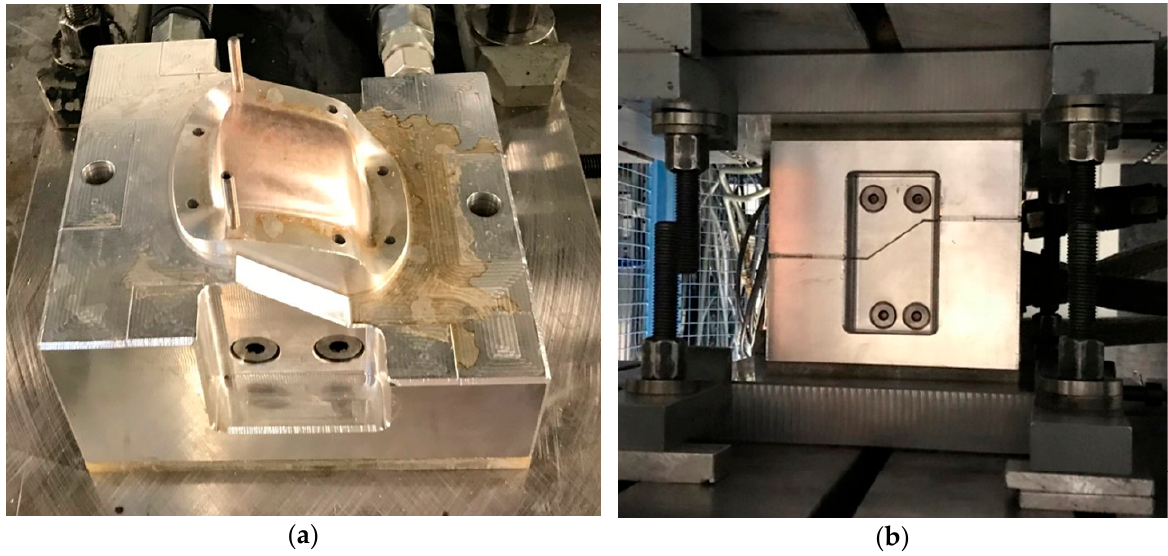
Figure 1. ( a ) Die with pins for the fixation of the veneer laminate; ( b ) closed tool in the forming press. Four different blanks of laminated veneer were used for the experimental and nu- merical trials. They have the same sample geometry as in the series production process (Figure 2). A CNC-controlled milling machine cut the samples. Ash wood veneers with different textures were used to analyze the influence of the growth ring structure on the forming result. This range corresponds to veneer samples such as those used typically in Mercedes-Benz vehicles. The grain direction was aligned parallel to the length direction of the vehicle for three specimens (Figure 2a–c), as this represents the more critical case. Additionally, the grain direction of one specimen was aligned perpendicularly (Figure